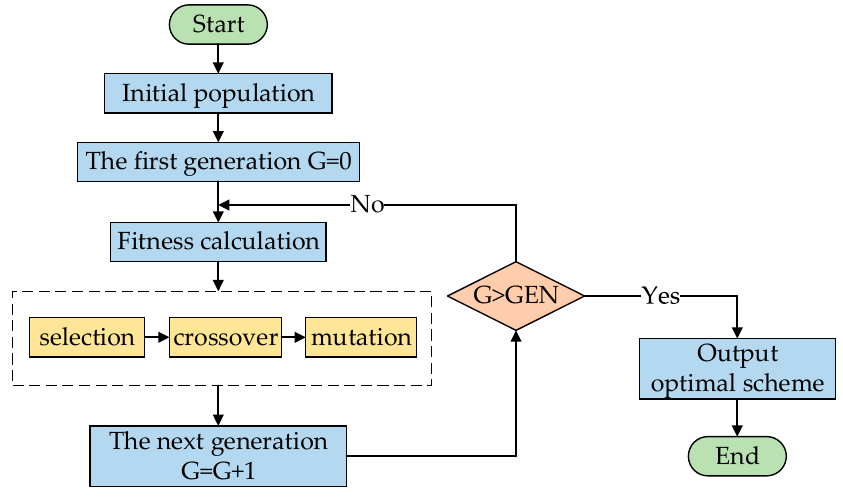
Figure 3. Basic operation process of genetic